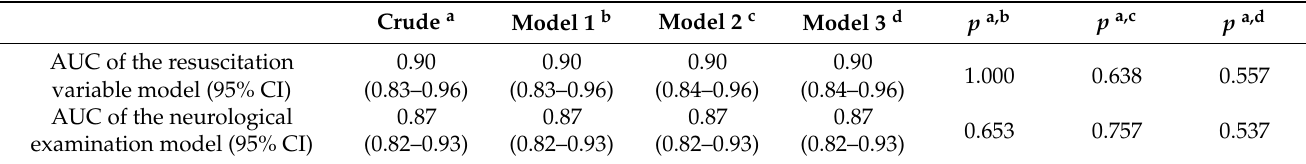
Table 3. Areas under the receiver operating characteristic curves of the different models predicting 6-month poor neurological